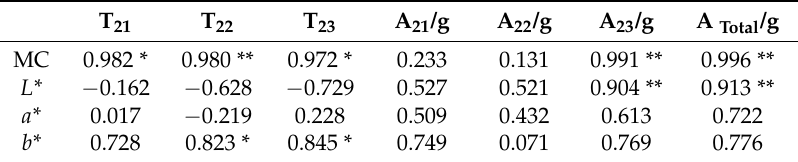
Table 5. Correlation coefficients among moisture content (MC), LF-NMR parameters, and color